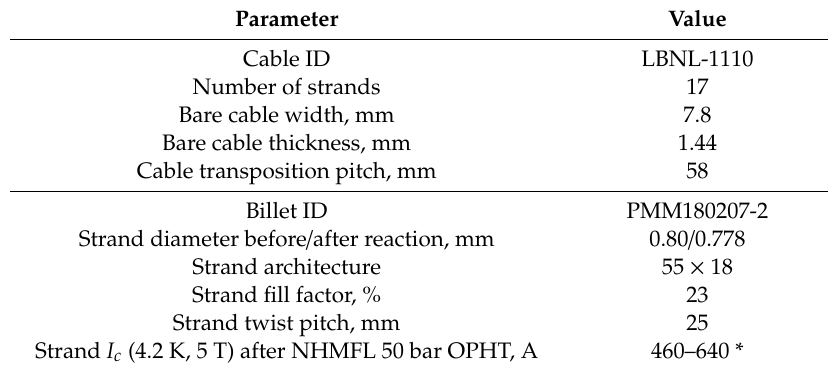
Figure 6. Bi2212 round wire ( left ) and 17-strand Rutherford cable ( right ) cross-sections (courtesy of LBNL). Table 4. Bi2212 cable and strand parameters.